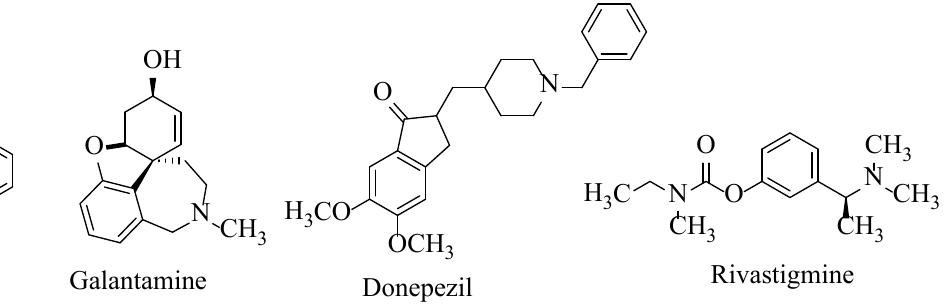
Figure 1. Available drugs for Alzheimer’s disease.